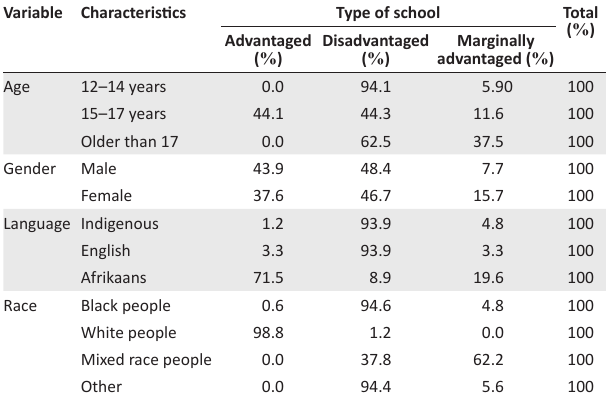
TABLE 2: Cross-tabulation of demographic variables with type of school. Variable Characteristics